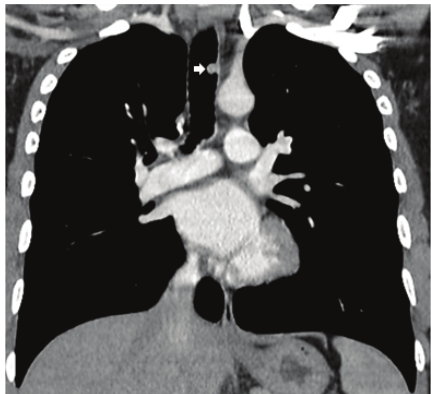
Figure 1: Computed tomography showed a homogeneously contrast enhanced polyp (white arrow) on the left lateral wall of the mid-trachea.